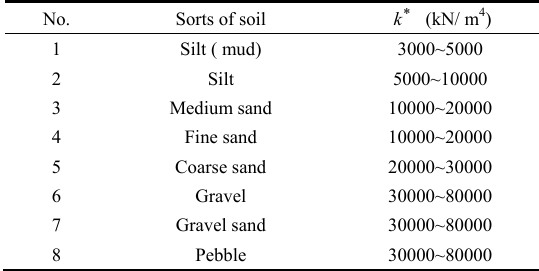
Table 3 Reference k  values of the soil.